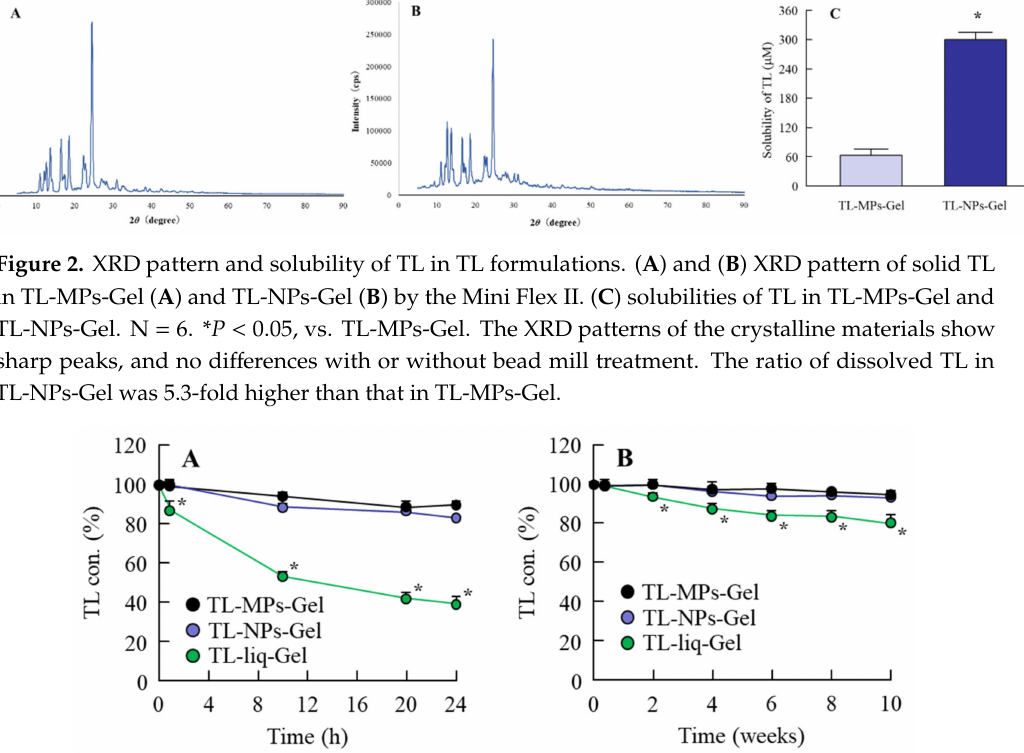
Figure 3. Photostability ( A ) and thermal stability ( B ) of TL in TL-NPs-Gel, TL-NPs-Gel and TL-liq-Gel. TL-MPs-Gel, formulation containing TL microparticles. TL-NPs-Gel, formulation containing TL nanoparticles. TL-liq-Gel, formulation containing dissolved TL (liquid TL). N = 5–8. * P < 0.05, vs. TL-NPs-Gel for each group. The photostability and thermal stability of TL-NPs-Gel was higher than those of